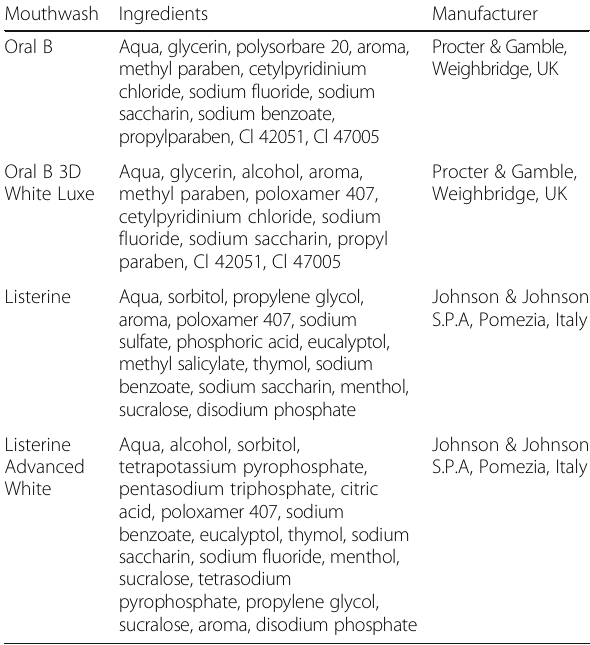
Table 1 Details of the tested whitening mouthrinses Mouthwash Ingredients